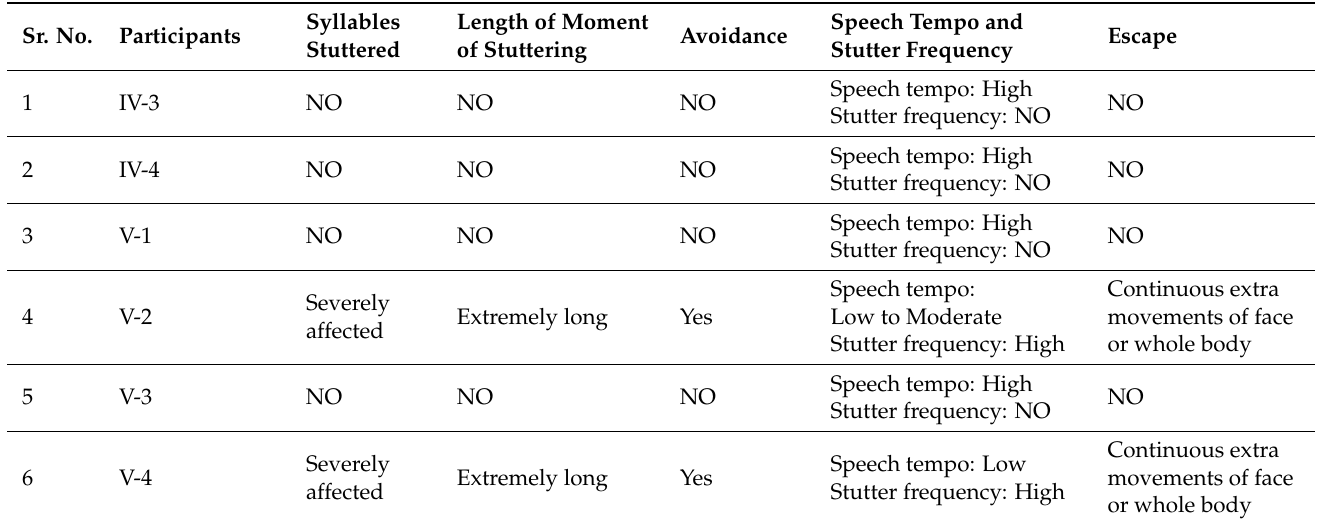
Table 1. Stuttering severity assessment of the participants in this